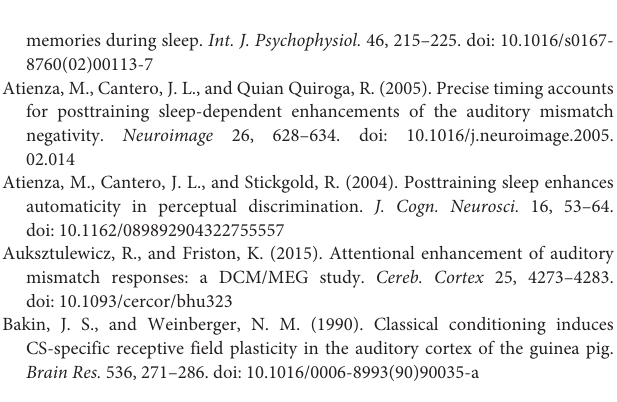
FIGURE S1 | Grand-averaged auditory ERP waveforms (Fz) for the standard sound and four types of deviants (without standard subtraction) superimposed for two oddball sessions before and after the MID task. FIGURE S2 | Training-related changes in the MMN and P3a amplitudes as a function of the dRT (difference in reaction time: the RT in low-probability minus the RT in high-probability trials, normalized by the average